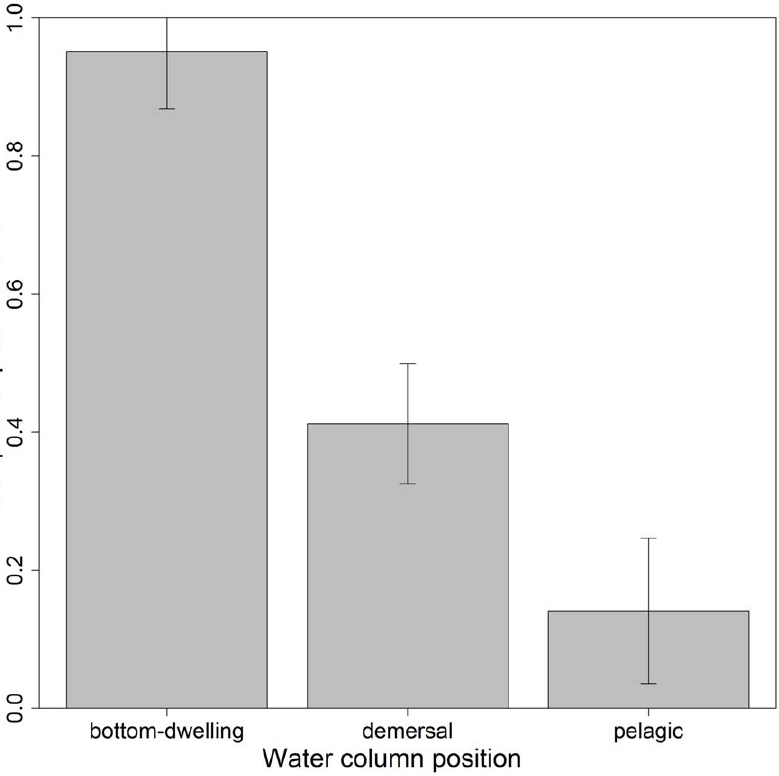
Figure 3. Predicted effect ( ± SE) of position in the water column on total PCS. The analysis is based on 3065 observations for bottom- dwelling species, 6445 observations for demersal species and 1991 observations for pelagic species.